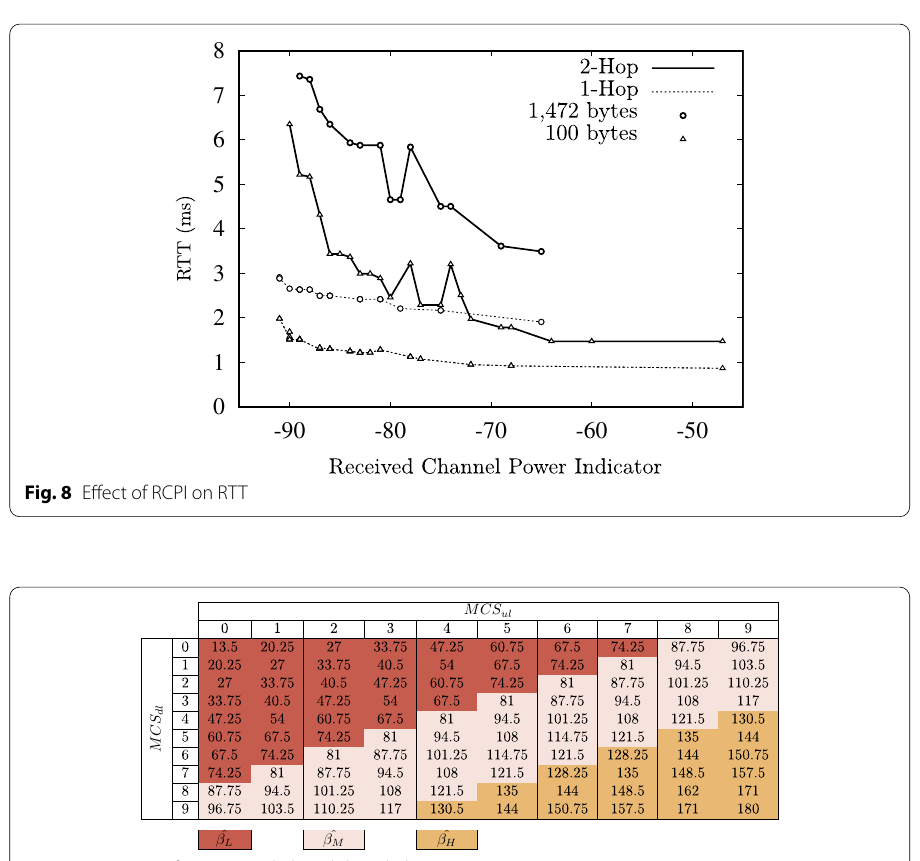
Fig. 9 Grouping of average uplink and downlink transmission rates